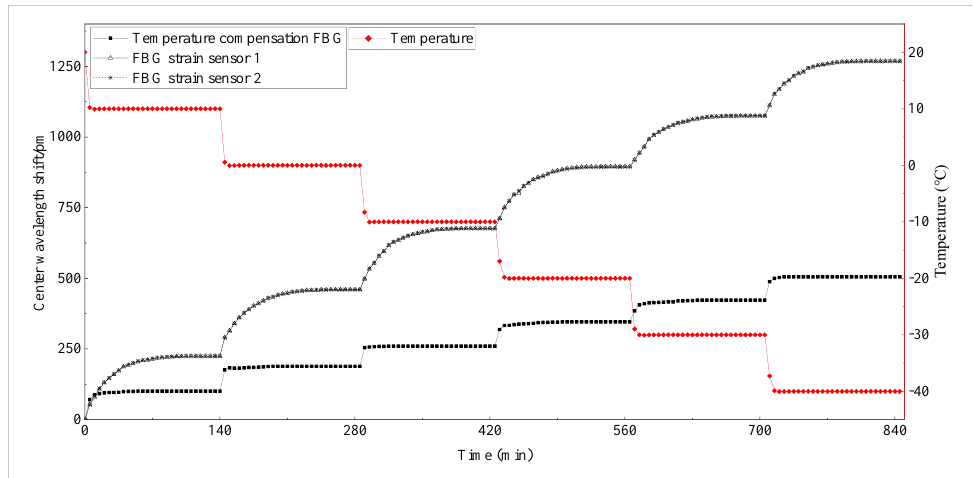
Figure 8. Center wavelength shift of FBG and temperature in the experimental chamber.